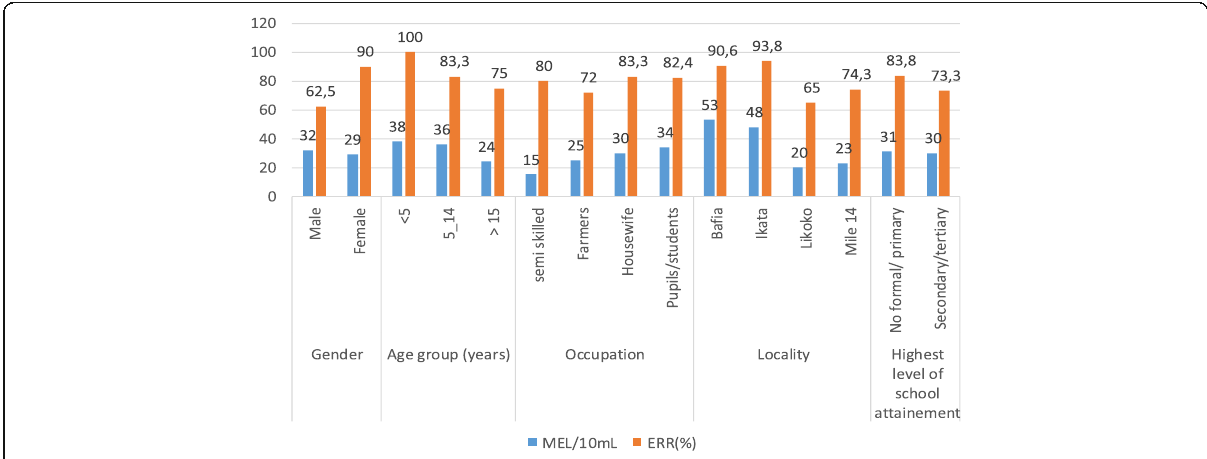
Fig. 1 Variation in ERR on day 42 post praziquantel treatment with mean egg loads per category on day